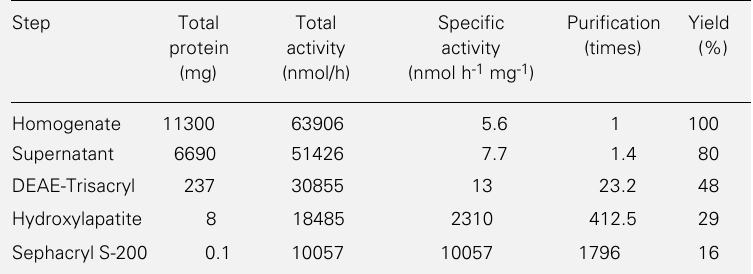
Table 1 - Purification of human brain